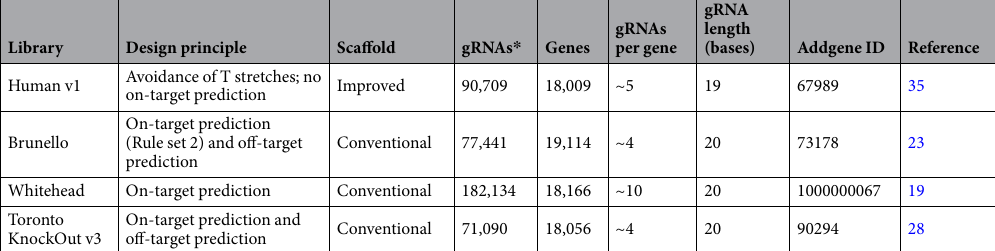
Table 1. List of second-generation human genome-wide CRISPR libraries. * Gene-targeting gRNAs only; excludes control gRNAs. This number differs from the gRNA totals in Fig. 1 because the latter are for the number of distinct 19-mer gRNAs.